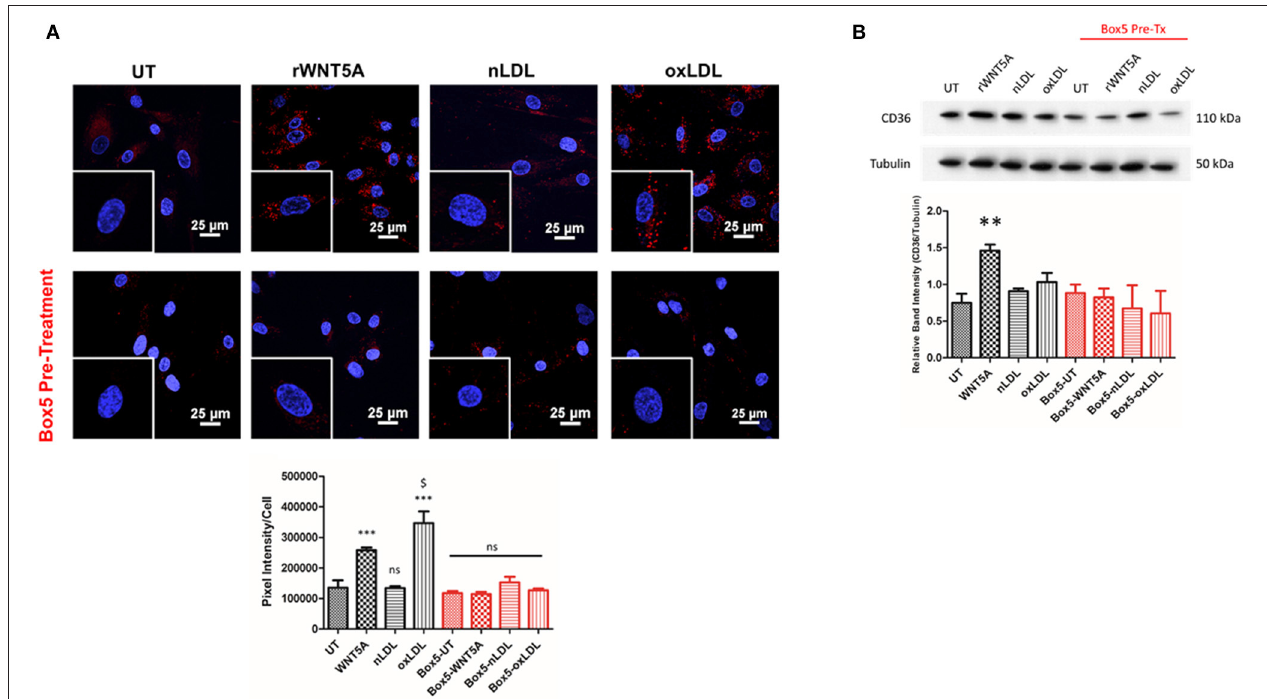
FIGURE 4 | WNT Proteins Regulate Lipid Accumulation in THP-1 Macrophages and VSMCs. (A) LipidTOX TM staining was used to evaluate the accumulation of neutral lipids within VSMCs. Representative 60x confocal images are shown. Equally zoomed insets are shown in the bottom left-hand corner of each image. The untreated (UT) controls were held for the duration of all in vitro experiments. Compared to UT and nLDL groups, cells treated with rWNT5A (100ng/ml) and oxLDL (100 µ g/mL) have increased red staining in the cytoplasm, indicating an increase in lipid within the cell. Box5 pre-treatment completely blocked lipid accumulation in response to rWNT5A and oxLDL. Quantification of lipid accumulation in each treatment group is representative of two independent experiments. (B) Western blots evaluating the expression of CD36 in VSMCs are shown. In response to rWNT5A (100ng/mL), expression of CD36 in VSMCs was significantly increased (**, p < 0.01), which was blocked by pre-treatment with Box5. *** = compared to UT control ( p < 0.001); $ = compared to rWNT5A ( p < 0.05).